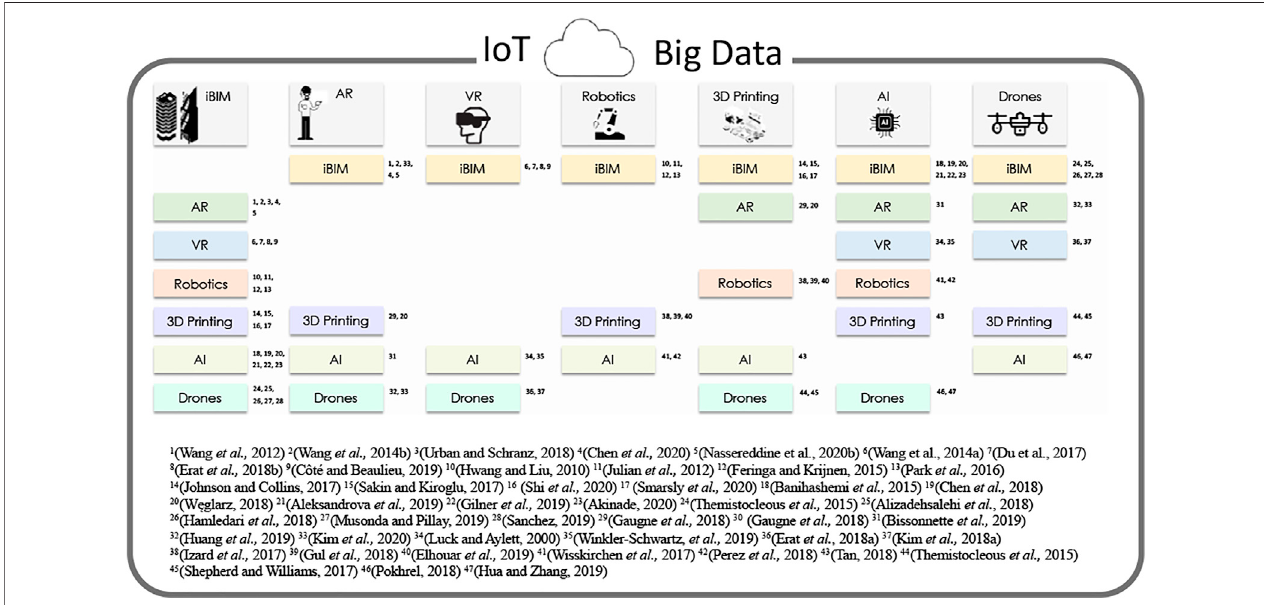
FIGURE 3 | Interaction map of Construction 4.0